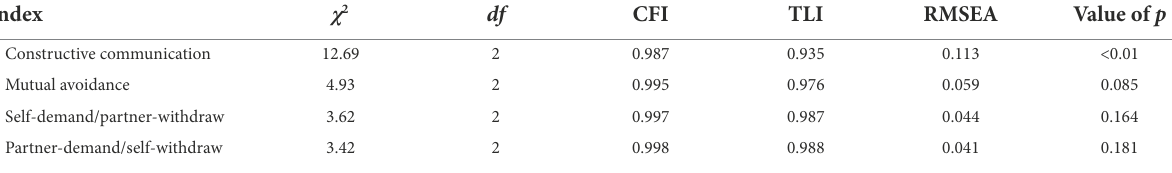
TABLE 4 The model indices.